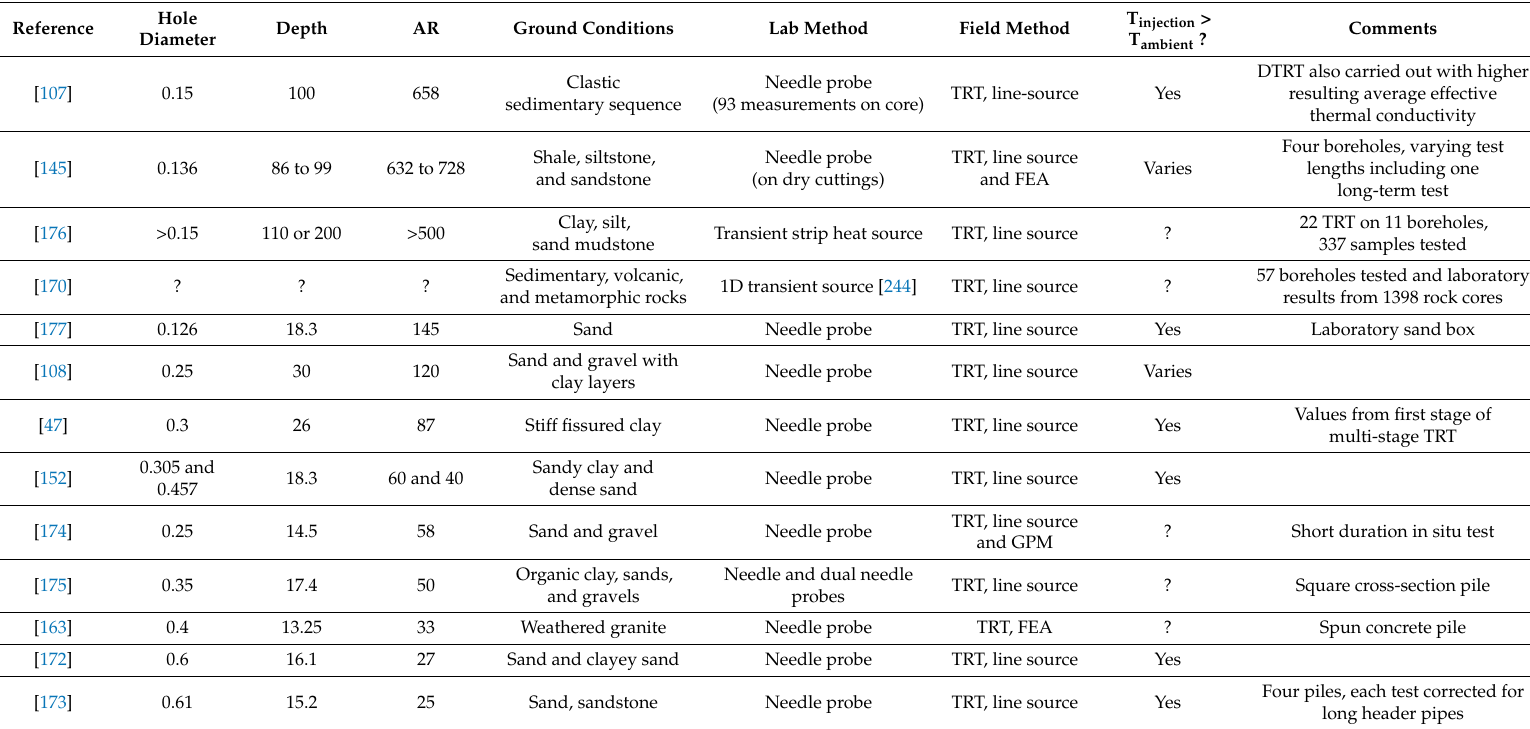
Table A3. Pile and borehole case studies measuring both laboratory and field thermal